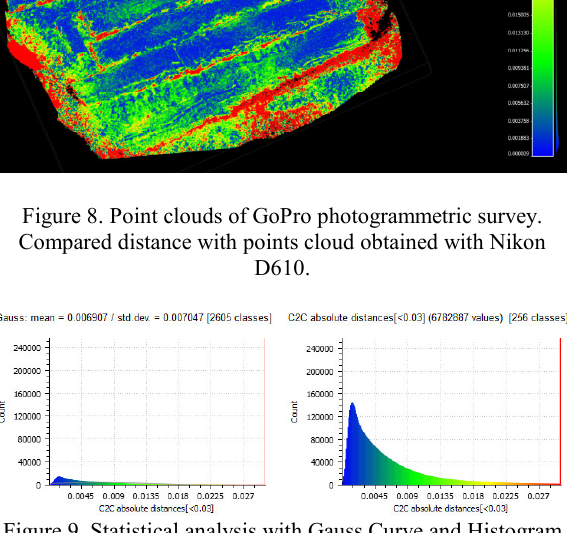
Figure 11. On the top, images of GoPro. On the bottom, the same subject on two frames from the video. Underwater, the typical radial distortion of fish-eye lenses disappear from the